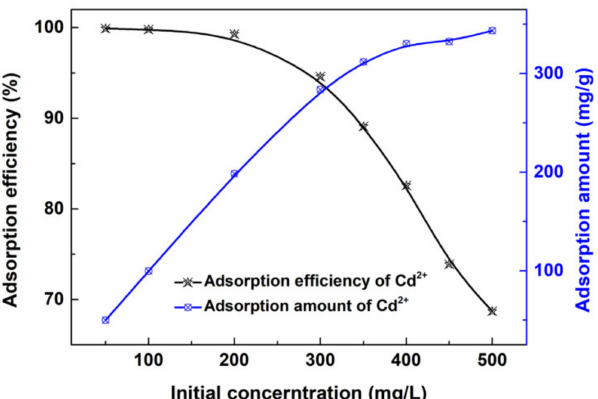
Figure 10. E ff ects of Cd 2 − initial concentration on the adsorption e ffi ciency and adsorption amount (adsorption conditions: room temperature; no pH pre-adjustments; [Fe 3 O 4 @SiO 2 -BPMA] = 1.0 g / L; [Cd 2 + ] = 50–500 mg / L; V = 50 mL; t = 30 min).